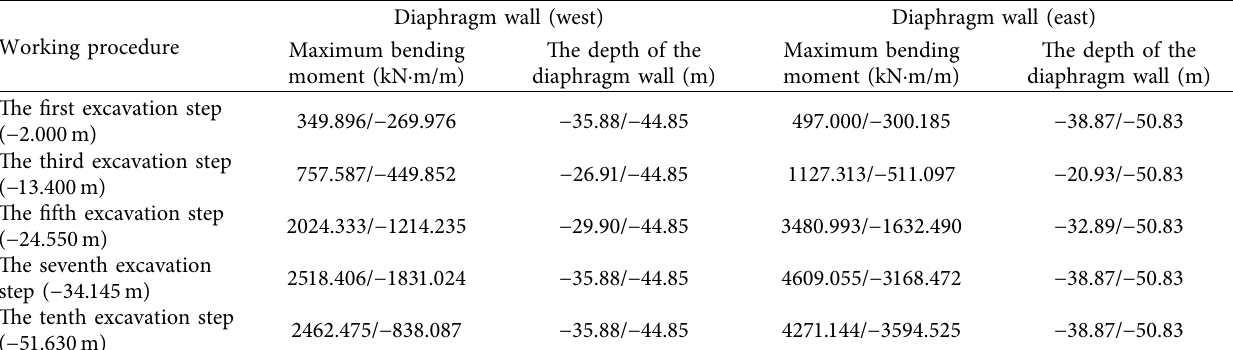
Table 5: Summary of maximum bending moment corresponding to the depth of the ground